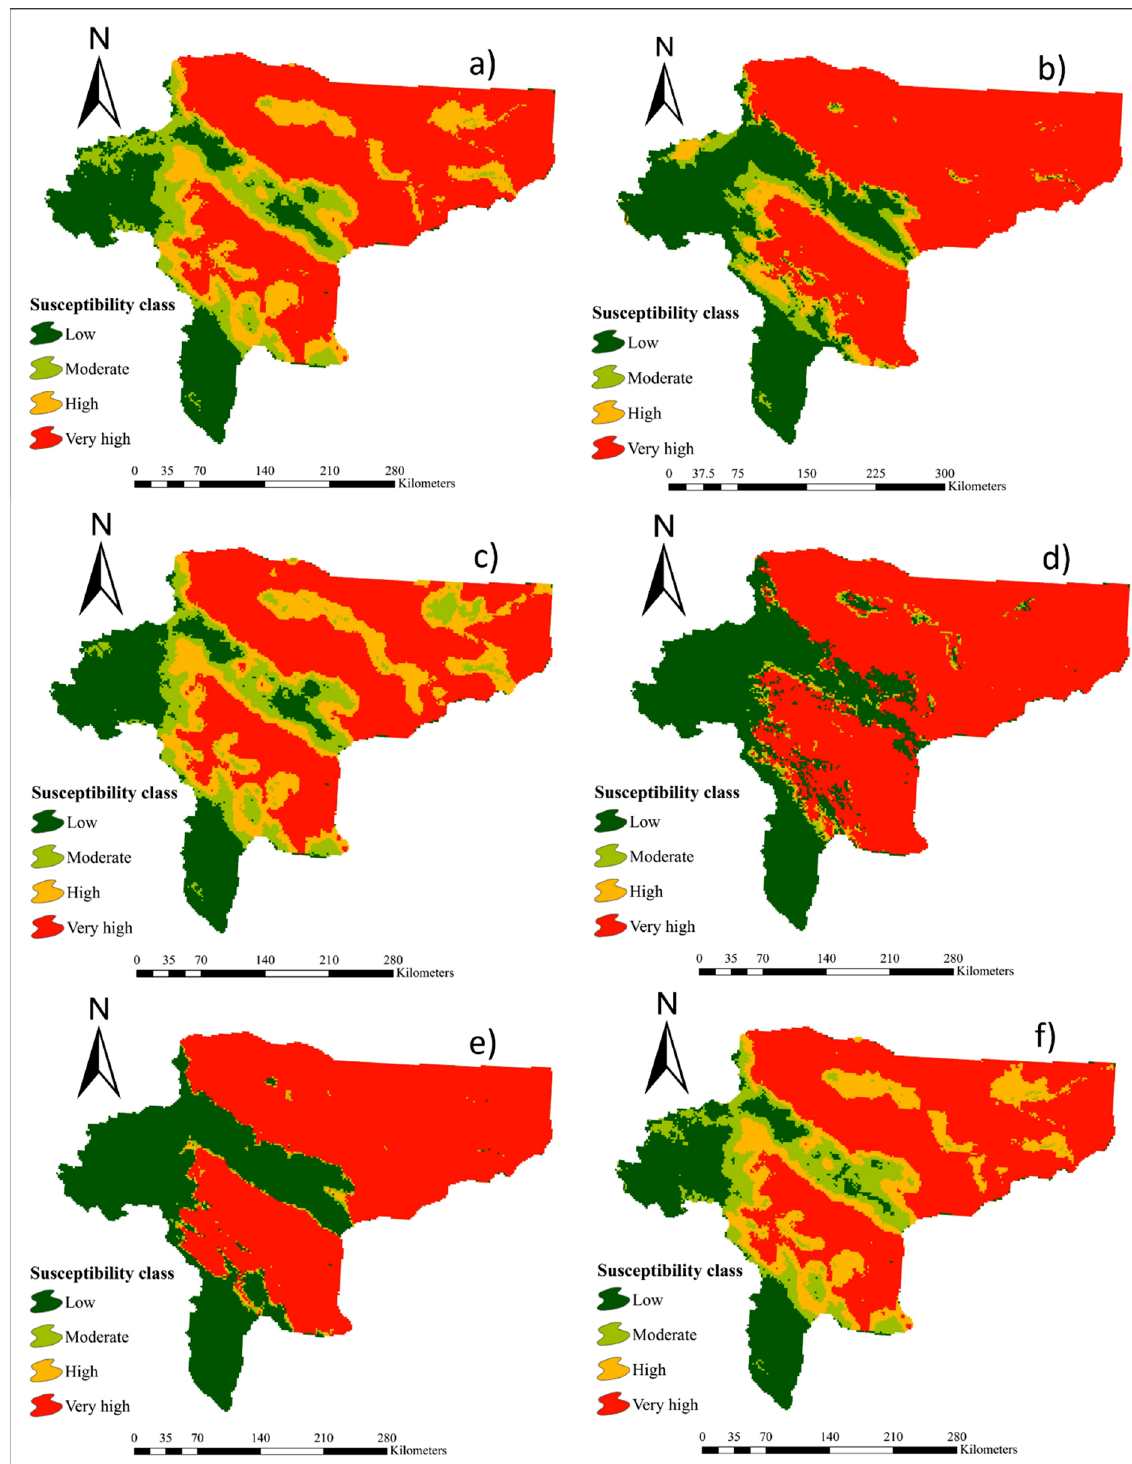
Figure 2. Maps of wind erosion hazard generated by: (a) RLR, (b) Cforest, (c) NCPQR, (d) NNFE, (e) MMLPNN, and (f) RR. The values for pixels was estimated by R software (https ://CRAN.R-proje ct.org/doc/ FAQ/R-FAQ.html) and then, values of pixels were mapped by ArcGIS 10.4.1 (https ://www.esri.com/en-us/about /about -esri/overv